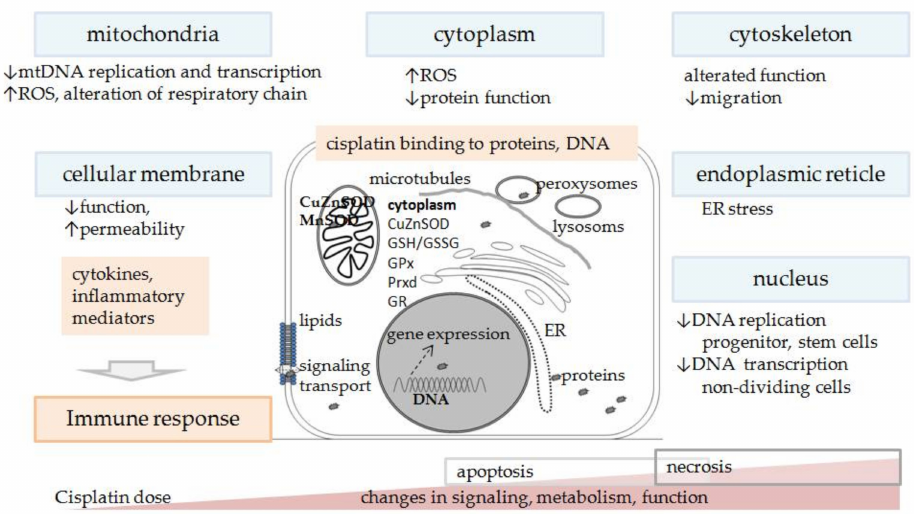
Figure 5. Schematic presentation of cisplatin toxicity in non-tumor cells in the body. Extent and intensity of oxidative stress, changes in signaling, metabolism, function, intensity of inflamma- tion, activation of certain immune cell types, inflammatory and molecular crosstalk and response, type of cell death, etc., depend on cisplatin dose (single or cumulative) and severity of toxicity. ER—endoplasmic reticulum; mtDNA—mitochondrial DNA; ROS—reactive oxygen